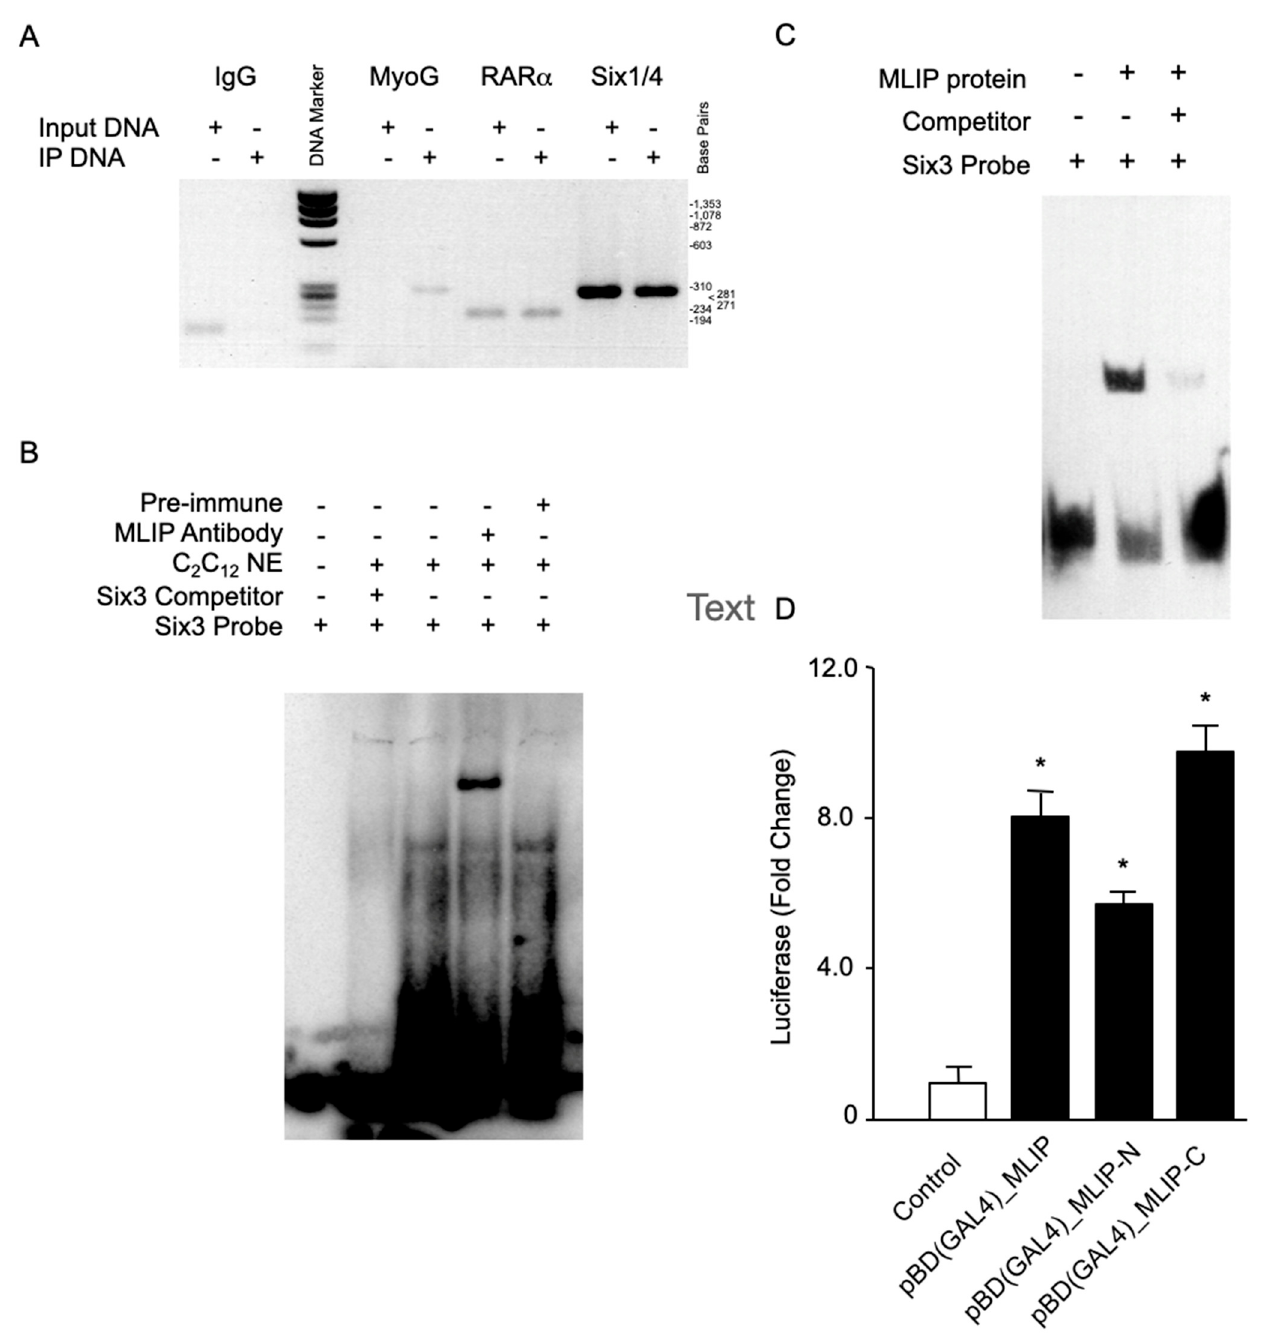
Figure 2. Mlip binds DNA and activates transcription. ( A ) Gene-specific PCR of Mlip genomic DNA targets. ( B ) Labeled SIX3 probe was mixed with 2 ug of C2C12 nuclear extracts (NE) and analyzed via gel shift assays. The complex was super-shifted by the addition of an Mlip specific polyclonal antibody. Mlip peptide neutralized antibody was unable to super-shift the SIX3 associated complex. ( C ) In vitro translated Mlip was tested for its ability to interact with labeled SIX3 probe by gel shift assay. The labeled SIX3 probe being competed away with a 50-fold molar excess of unlabeled SIX3 probe. ( D ) Mlip full-length, N-terminal (exons 1–3) and C-terminal Mlip (exons 5–12) fused to a GAL4 DNA binding domain trans-activates a GAL4-Luciferase promoter in HEK293 cells. The assay was repeated 3 times, * = p < 0.01 versus control, pBD-p53 (Agilent). ‘+’ = addition of reagent. ‘-’ symbol means ‘no reagent